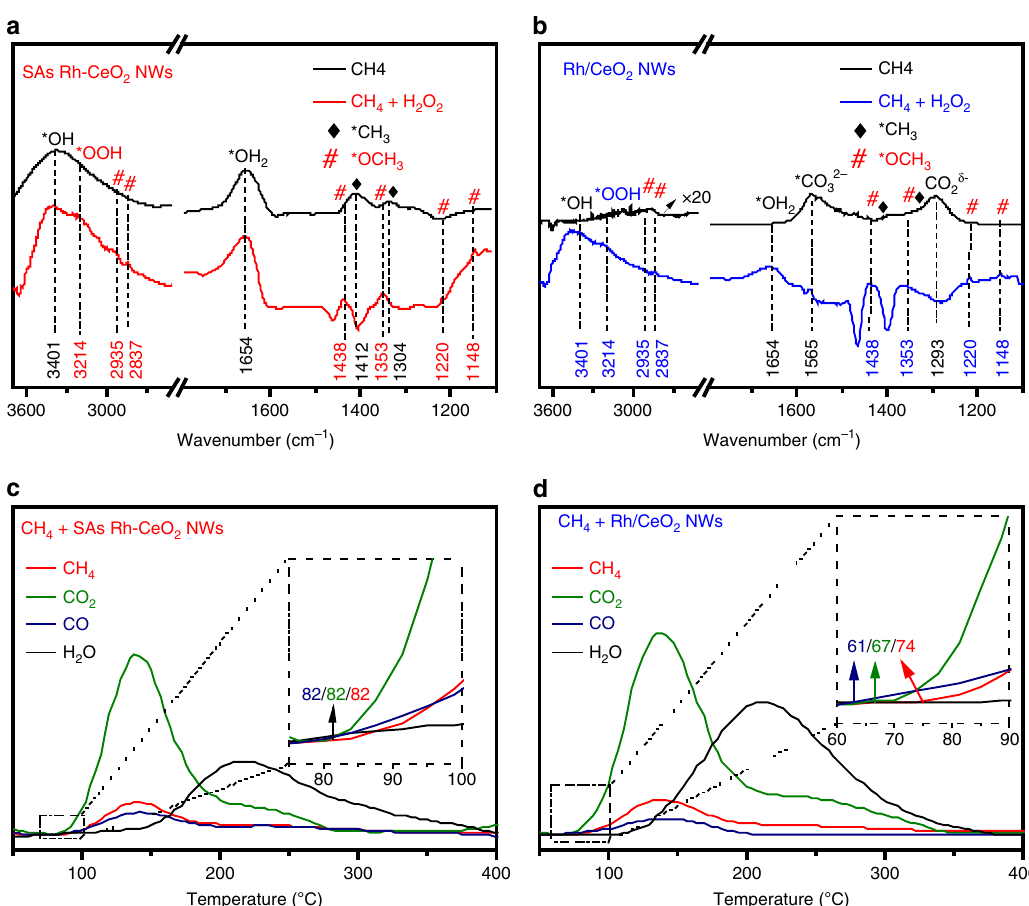
Fig. 3 In situ CH 4 -DRIFTS and CH 4 -TPSR measurement. a , b In situ CH 4 -DRIFTS measurements on SAs Rh-CeO 2 NWs ( a ) and Rh/CeO 2 NWs ( b ). c , d CH 4 -TPSR measurements on SAs Rh-CeO 2 NWs ( c ) and Rh/CeO 2 NWs ( d